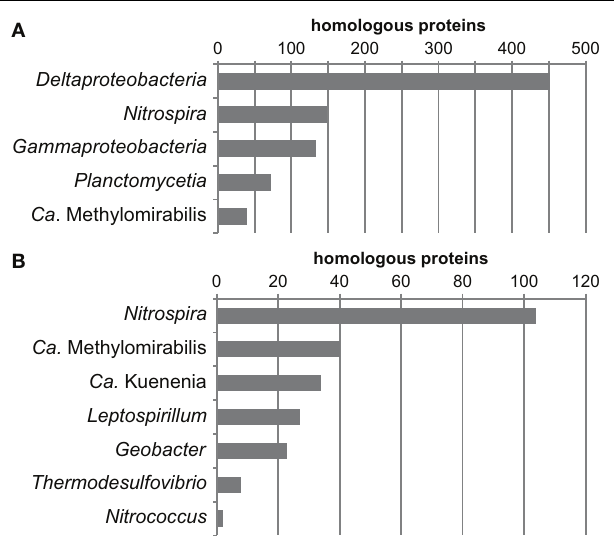
FIGURE 2 | Summarized results of a phylogenetic analysis of the phylome of N. gracilis 3/211. The nearest phylogenetic neighbor (closest homolog) in other sequenced genomes was determined for each protein of N. gracilis .The resulting trees were queried for the closest homolog using Phat (Frickey and Lupas, 2004).The graphs depict the phylogenetic groups displaying the largest numbers of most closely related homologs on the (A) class and (B) genus level. In total, Phat could unambiguously assign closest homologs for 2,246